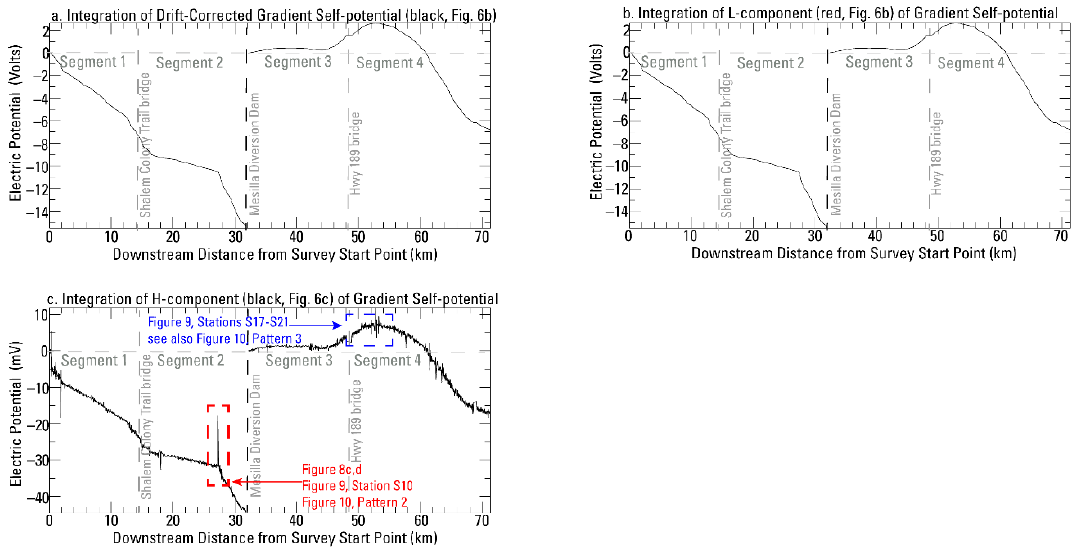
Figure 7. Electric potential profiles in the Rio Grande across the Mesilla Valley, determined by numerical integration of drift-corrected gradient SP data and the corresponding L and H components using Equation (3). The starting and ending points of survey segments 1–4 are depicted in Figures 1–3. ( a ) Integration of drift-corrected gradient SP data prior to decomposition into L and HN components. ( b ) Integration of the L component. ( c ) Integration of the H component after removing an estimate of the N component produced by filtering with a windowed moving average filter described by [37]. The spike observed along survey segment 2 is about 200-m wide and collocated with the drop in gradient SP data along survey segment 2 (Figure 6b) and discrete spikes in measured surface-water temperature and specific conductance (Figure 8). Note the differences in scale of the y-axes based on the integrated component.